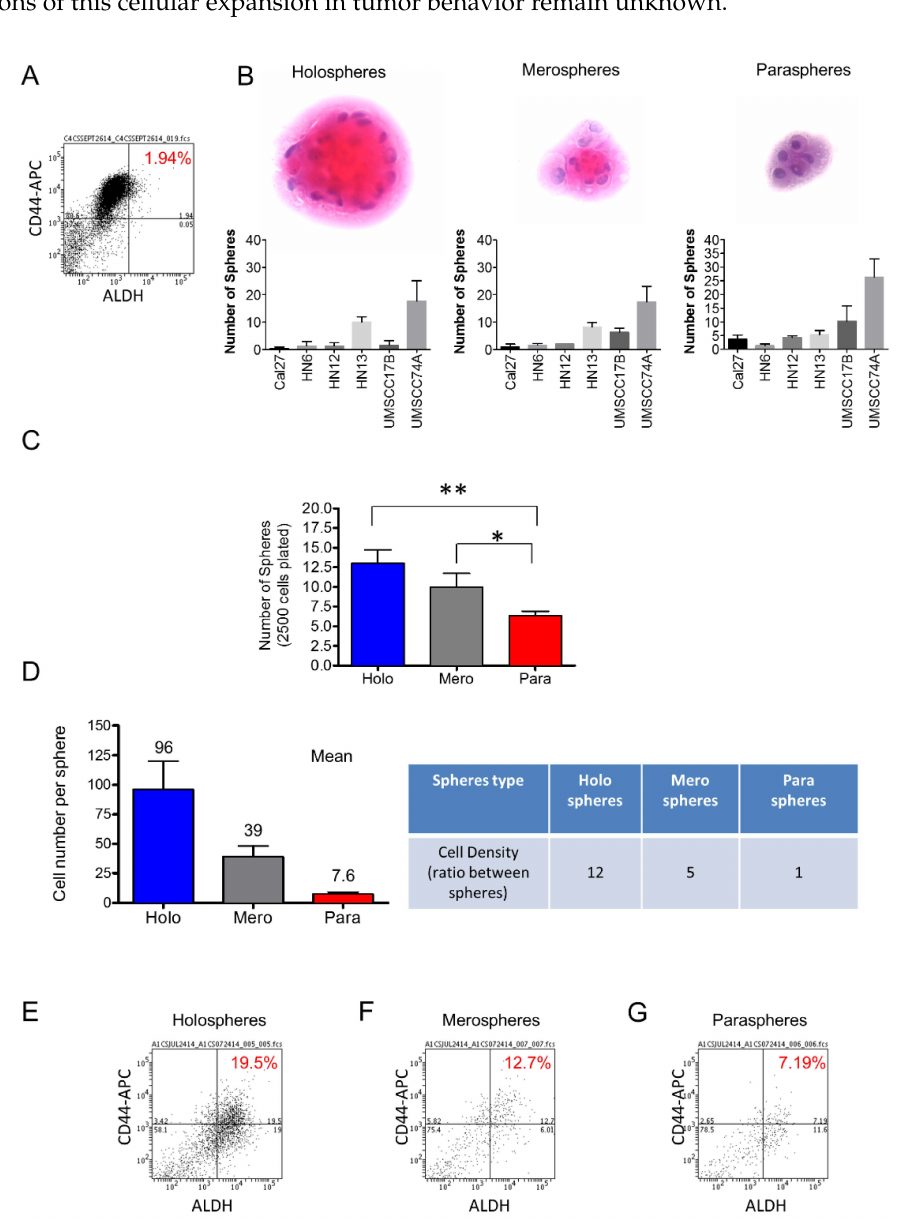
Figure 1. Ultra-low attachment culture conditions enhance the number of CSCs . ( A ) Cell sorting to determine the total number of tumor cells from an HNSCC cell line cultured in monolayer. N , N -diethylaminobenzaldehyde (DEAB) was used to inhibit ALDH activity resulting in the identification of negative cells for ALDH; ( B ) H and E staining of tumor spheres depicting the typical morphological appearance of holospheres, merospheres, and paraspheres. HNSCC tumor cell lines Cal7, HN6, HN12, HN13, UMSCC17B, and UMSCC74A are able to generate holospheres, merospheres, and paraspheres; ( C ) Total number of tumor spheres from a culture of 2.5 ˆ 10 3 tumor cells under ultra-low adhesion conditions (** p < 0.01, * p < 0.05); ( D ) Mean of the total number of cells per sphere subtype and the ratio of cellular density between different spheres types; ( E – G ) Percentage of tumor cells positive for CD44 and ALDH stem cell